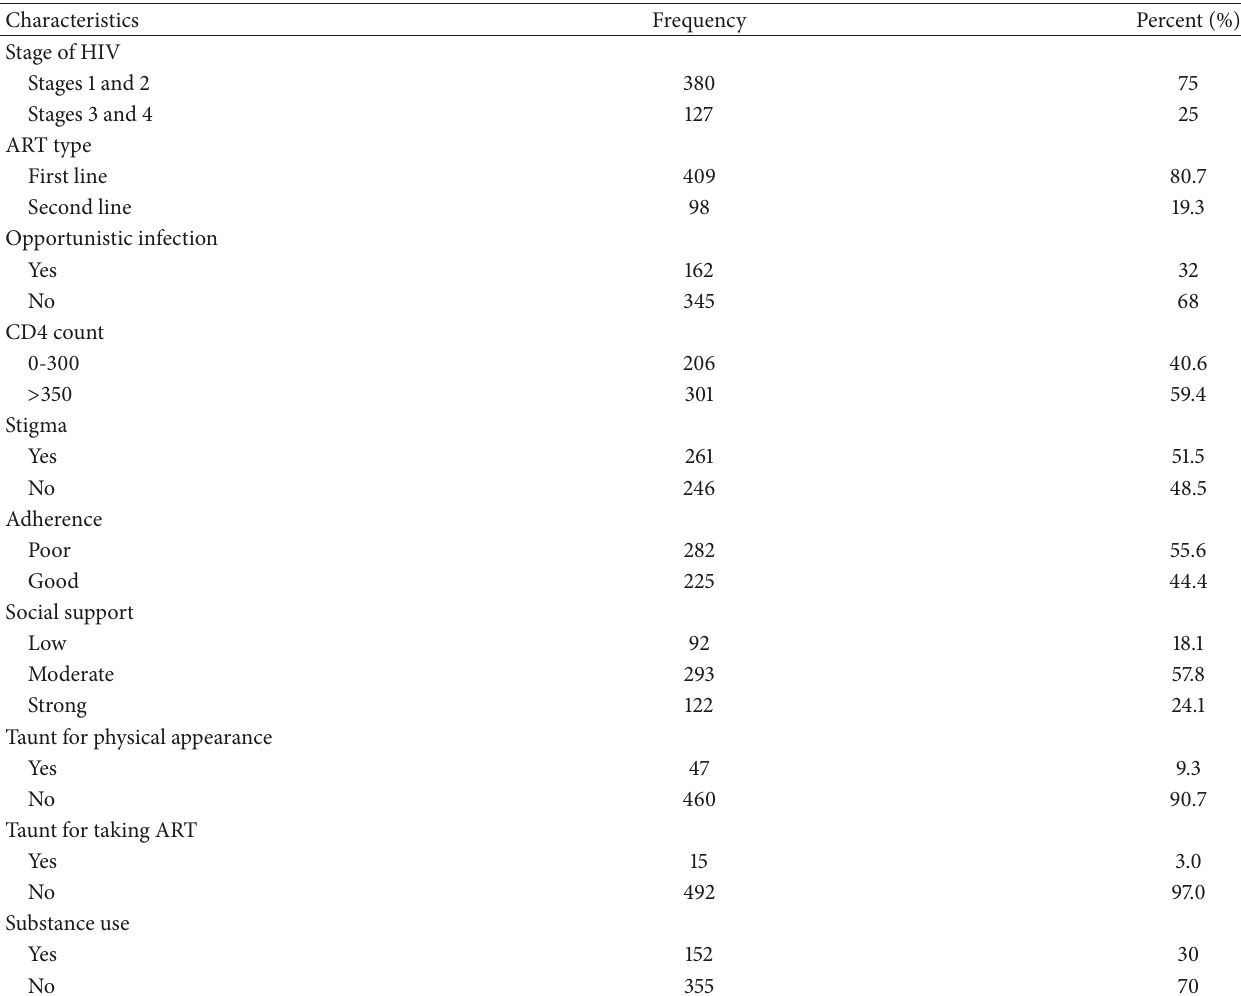
Table 2: Distribution of clinical, stigma, and psychosocial factors among HIV positive youth attending ART follow-up at public hospitals in Addis Ababa, Ethiopia,